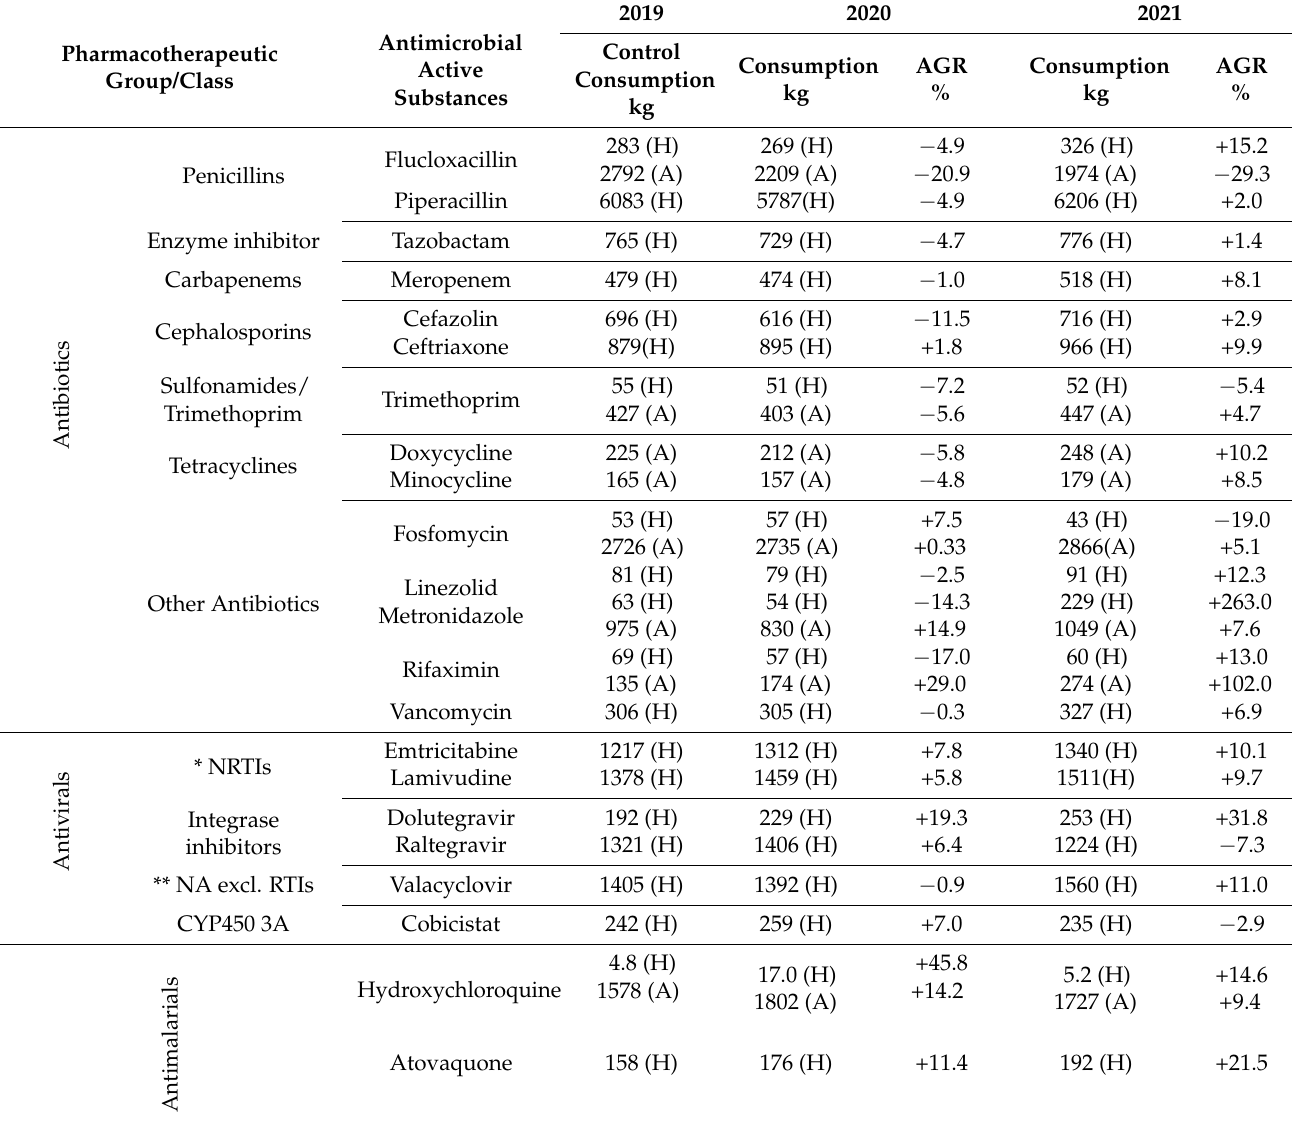
Table 1. Assessment of AGRs for the antimicrobials’ active substances during the COVID-19 pan- demic period (2020 or 2021) compared with 2019 used in hospitals and dispensed in ambulatory